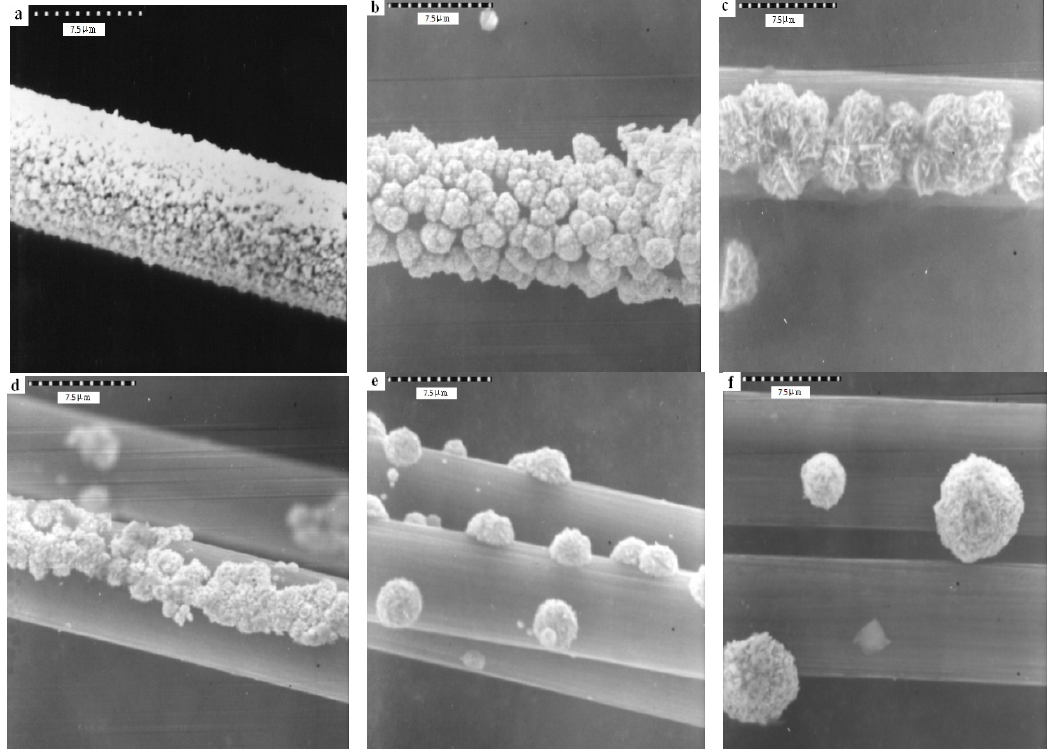
Figure 13. Gold particle distribution in the Au -coated carbon fiber as the working electrode in the flow cell after ( a ) 0 h; ( b ) 2 h; ( c ) 5 h; ( d ) 7 h; ( e ) 9 h; ( f ) 12 h.